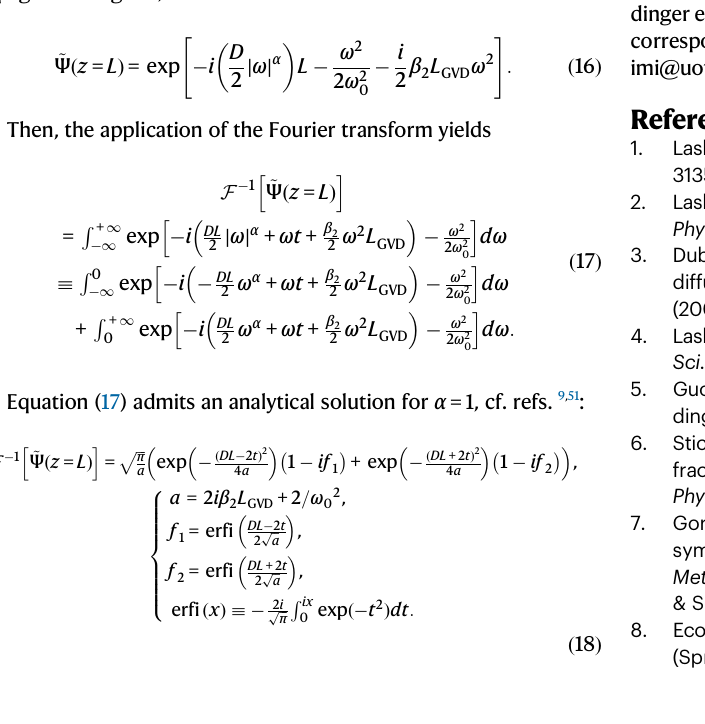
cases ( a ) and ( b )). The parameters are β 2 = − 21×10 − 3 ps 2 /s and D =21×10 − 3 ps/s, − 1 . The color-coding in these panels represents the relative intensity, ω 0 =10ps which is normalized so that to uniformly represent values from zero to